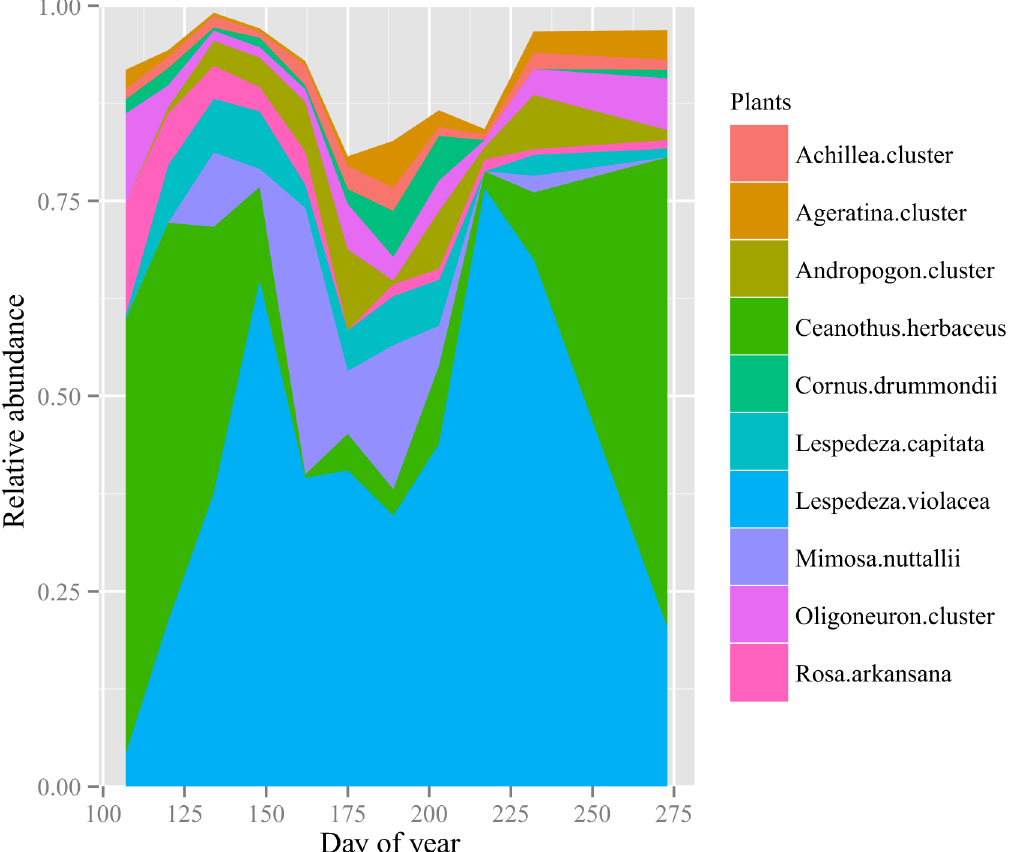
Fig 2. Plant relative abundance as indicated by sequencing of trn L chloroplast genes. Plants were identified to species by matching database sequences at the 100% level. See Results for the identity of species in clusters. The effect of time in each dataset was tested using repeated measures ANOVA with Bonferroni correction. Three taxa ( Lespedeza violacea , Ceanothus herbaceus , and the Oligoneuron forb cluster) exhibited significant temporal change in proportion of the diet (P < 0.01).